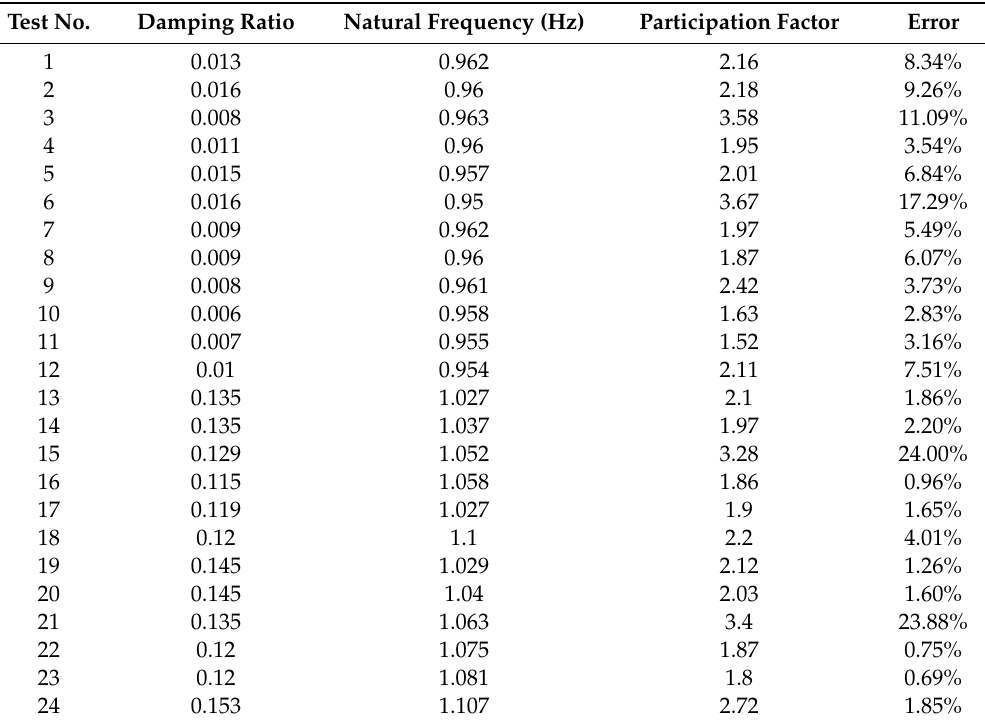
Table 3. Horizontal parameter identification results.